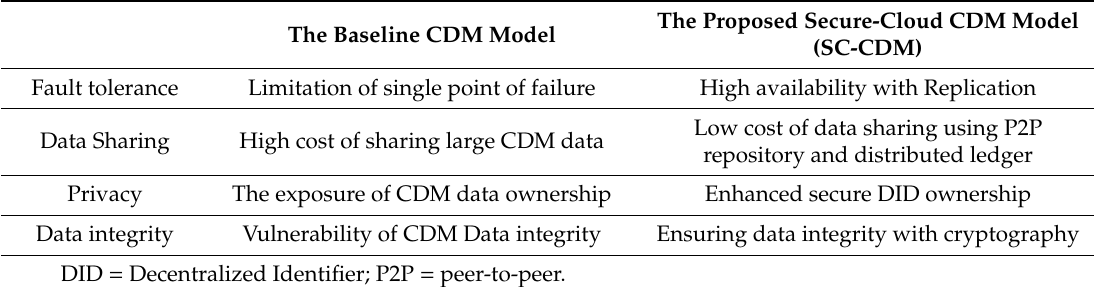
Table 2. Comparison of qualitative factors in the CDM